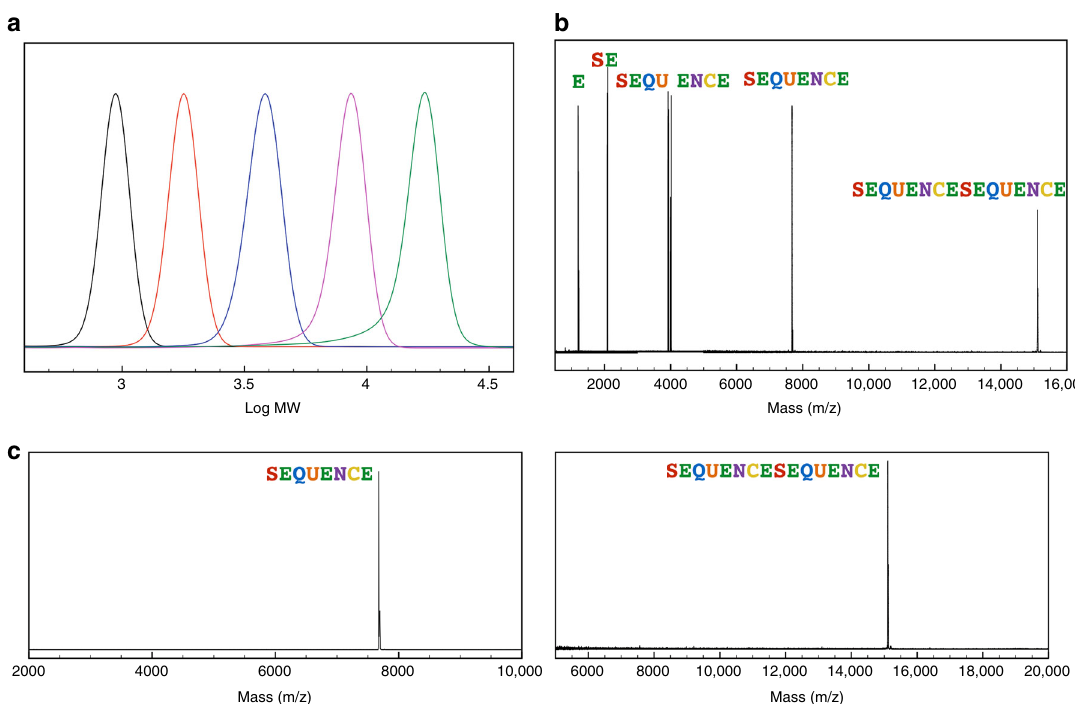
Fig. 2 Molecular-weight analysis of PcL. a Gel-permeation chromatography (GPC) analysis of PcLs with 8, 16, 32, 64, 128 repeating units. b Combined MALDI-TOF mass spectra of PcLs encoding the letter (E, 1201.5 Da), two-letter word (SE, 2082.9 Da), four-letter words (SEQU, 3920.4Da and ENCE, 3996.5 Da), 64-bit word (SEQUENCE, 7674.5 Da), and 128-bit word (SEQUENCESEQUENCE, 15105.3 Da). The peak was assigned to a [M + Na] + ion. c MALDI-TOF spectra of 64- and 128-bit PcL showing no deletion errors or contamination of lower molecular-weight